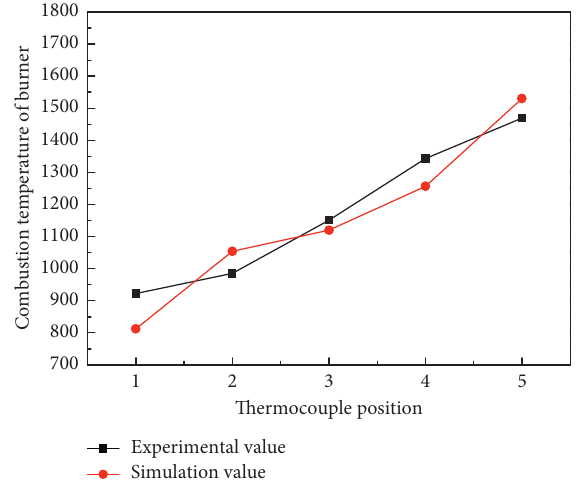
Figure 5: Comparison of simulation and experimental values of the burners’ combustion